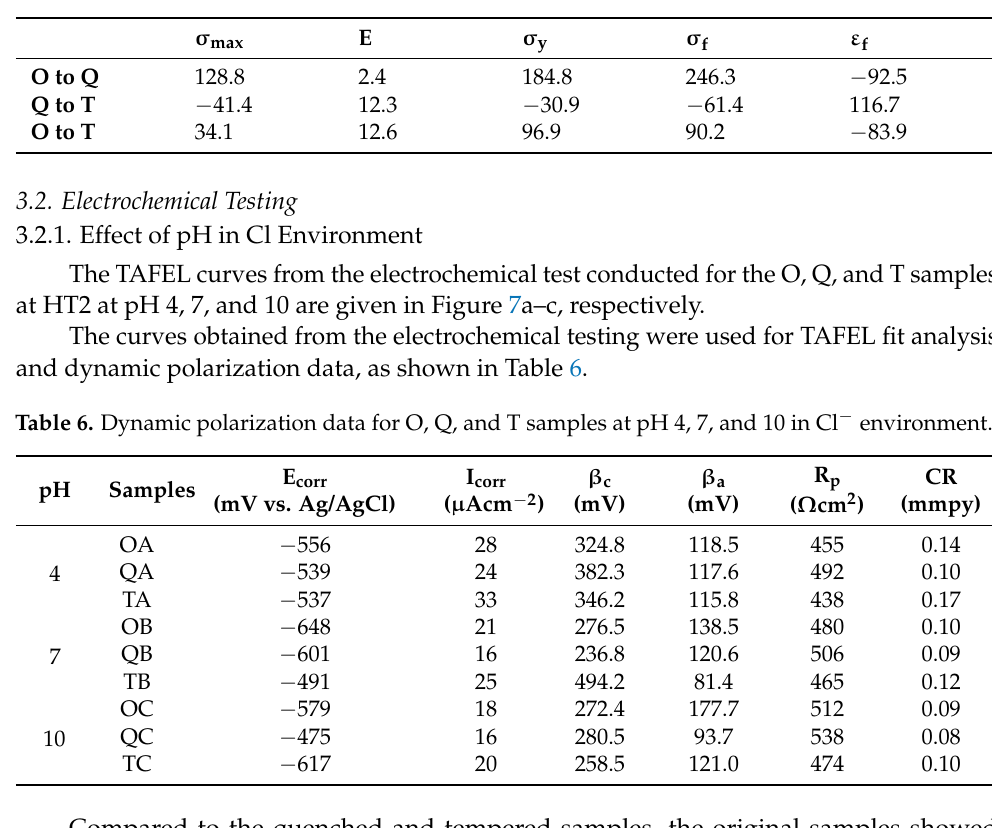
Table 5. Percentage changes in the material properties, featuring improvement (+) or deterioration ( − ).